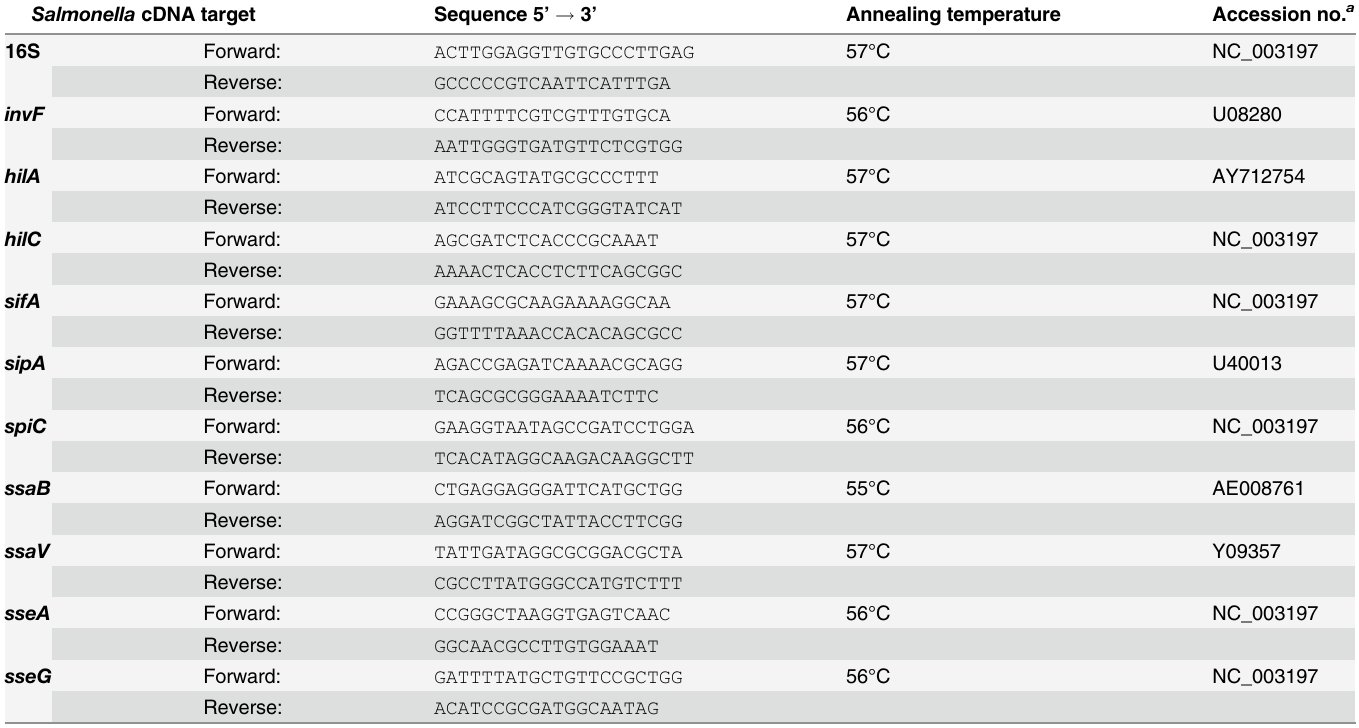
Table 1. Salmonella primer sequences for quantitative real-time